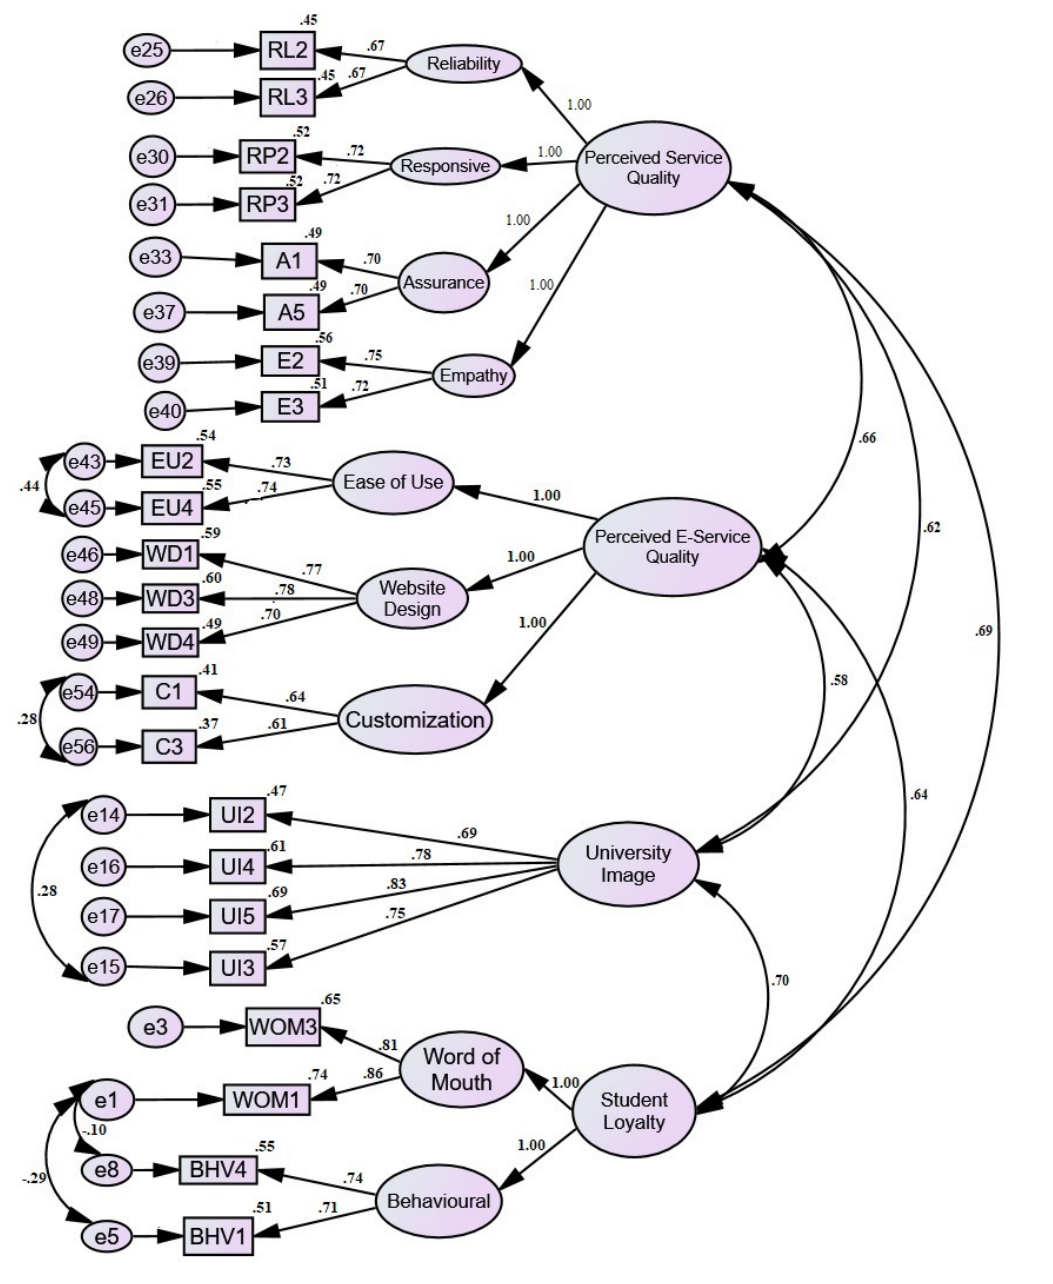
Figure 2. Assessment of full measurement model. RL = reliability; RP = responsiveness; A = assurance; E = empathy; EU = ease of use; WD = website design; C = customization; WOM = word of mouth; BHV =